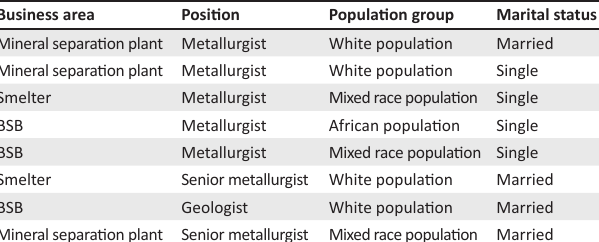
TABLE 1: Biographical information of the